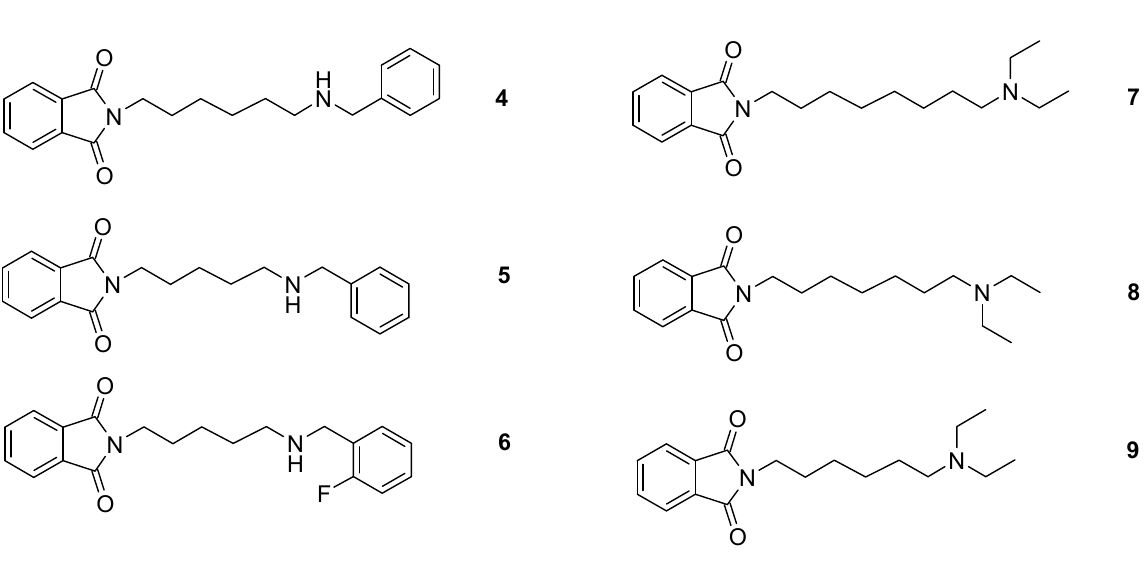
Figure 10. Structures of designed acetylcholinesterase inhibitors—newly synthesized ( 4 – 6 ) and currently described compounds ( 7 – 9